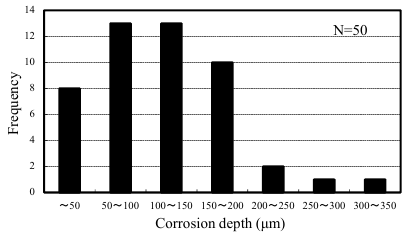
Figure 4. Pitting corrosion depth distribution of tendon in CP after completion of service.